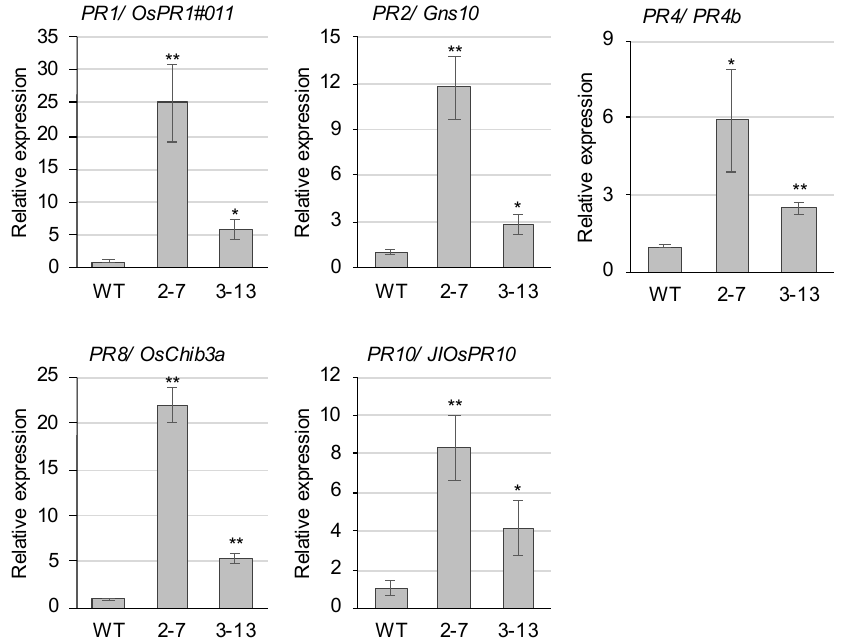
Figure 6. PR gene expression is increased in the ugt74j1 mutants. qRT-PCR was performed using total RNA isolated from the fifth leaves of the wild type and mutants grown under non-stressed conditions. The expression level of each PR gene was normalized to the expression of OsACT1 . These data represent the means of eight independent experiments ± SE. Significant differences compared with the wild type were calculated using Student’s t -tests: * p < 0.05; ** p < 0.01.